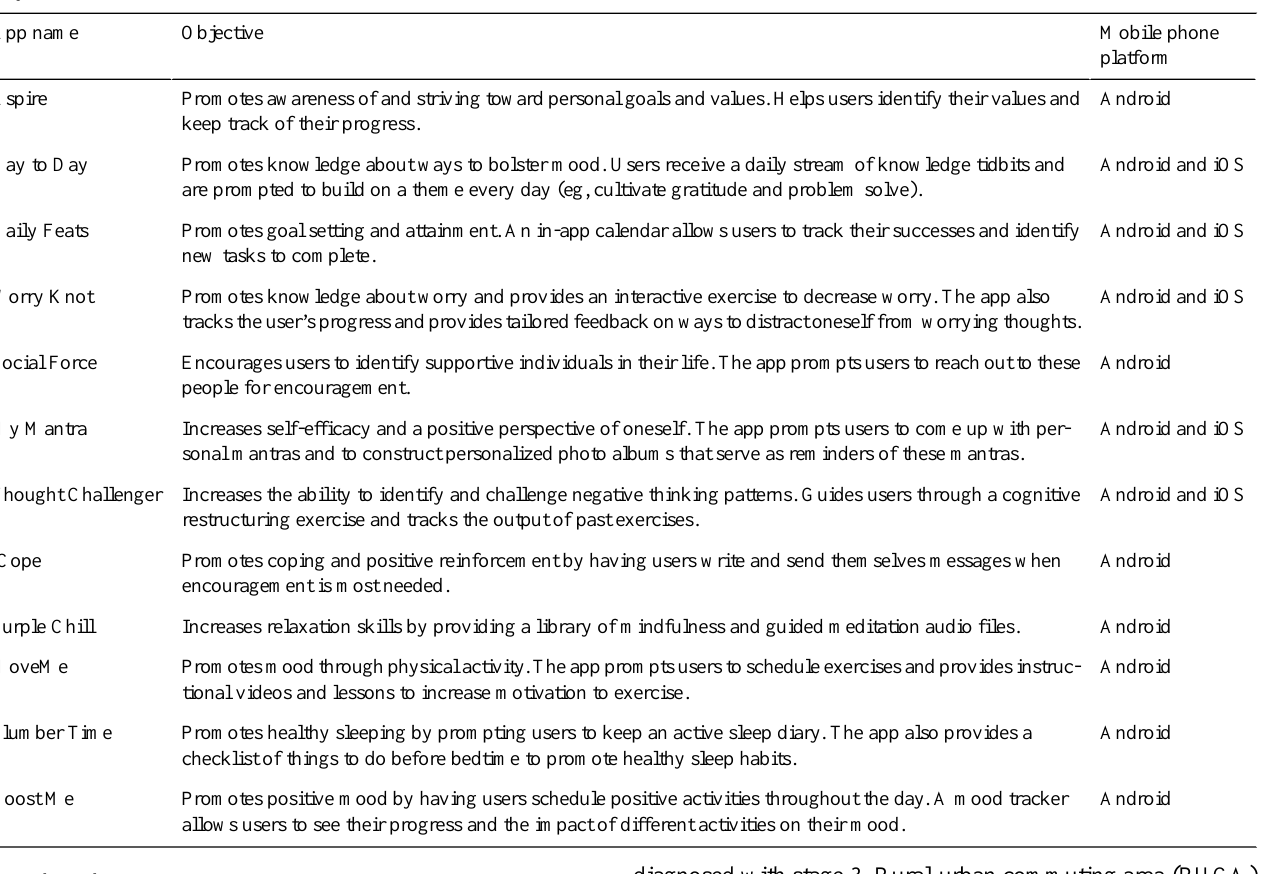
Table 1. Description of IntelliCare apps, their objectives, and which apps were available for each type of mobile phone platform at the time of the study.